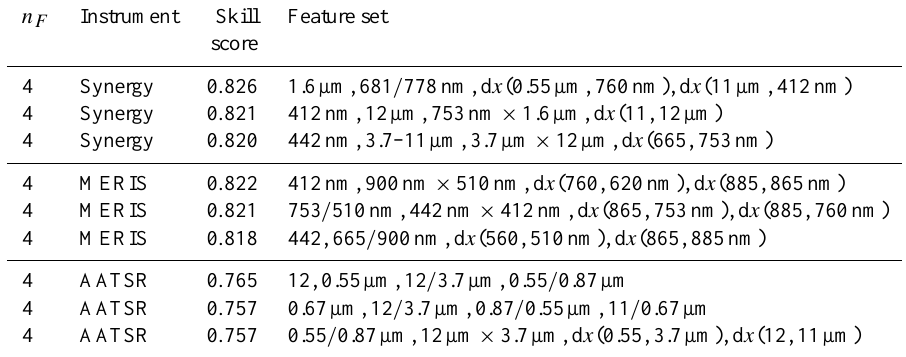
Table 2. Similar to Table 1 but for classical Bayesian cloud masks based on four strongly independent features. n F